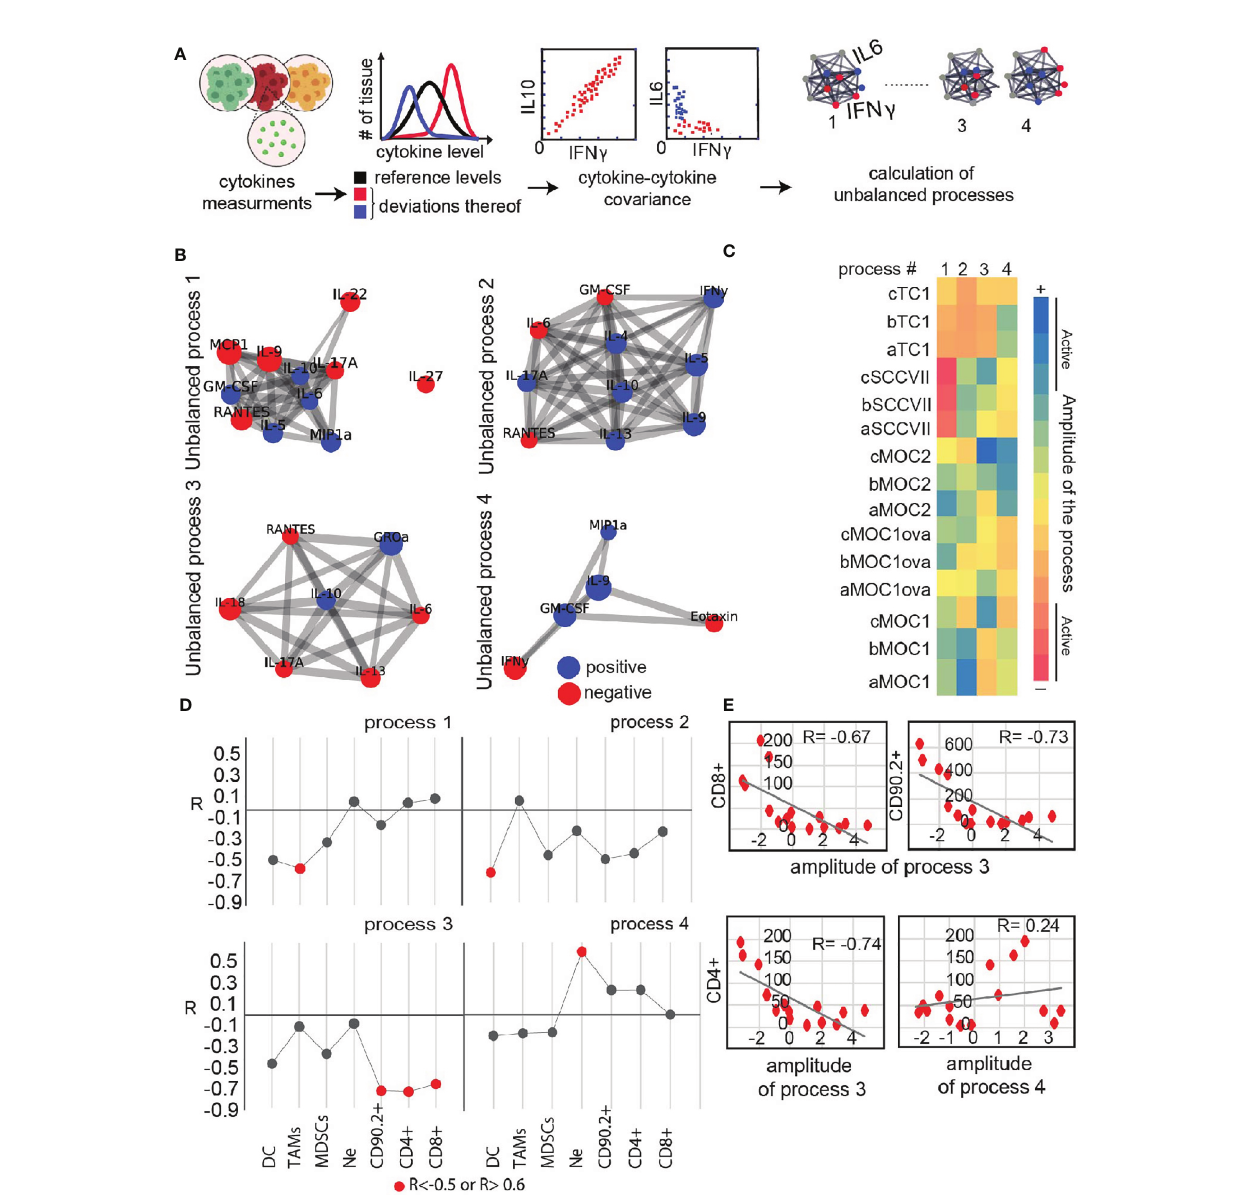
FIGURE 4 | Utilizing secretome pro fi ling to identify cytokine/chemokine expression patterns in different explants and their correlation with immune in fi ltrating cells. (A) Quantitative secretome data obtained from the cohort of HNSCC tumor models explants is used as an input for the analysis. Extent of variability in protein expression levels is quanti fi ed for each cytokine/chemokine. Protein distribution histograms are built to present and quantify this variability. Proteins whose expression levels deviate from the reference state in the same direction or in opposite directions, e.g. co-varying proteins, are grouped further into correlation networks (exempli fi ed here by IFNg, IL10 and IL6). In this example IFNg and iL10 are correlated, whereas the expression levels of IFNg and IL6 are anticorrelated and deviate from the steady state in an opposite manner. Based on these co-varying groups of proteins, altered protein-protein correlation networks are generated (right panel). Several different protein-protein correlation networks can be found in the entire population of cancer explants. (B) Four signi fi cant unbalanced processes were found in the explant dataset based on error calculation. Cytokines with signi fi cant G i a values (the cutoff was based on 20-fold difference between the 20% of cytokines with lowest G i a in this process and the cytokines considered to be involved in the process) were assembled into networks using functional interactions according to STRING database. (C) Heatmap presents amplitude values of the 4 unbalanced processes for all tumor types. Threshold limits (indicated as “ active ” in the color chart) were calculated as described (22). (D, E) Correlation plots between amplitudes of the unbalanced process and the levels of biomarkers representing in fi ltrating immune-cells were generated for each process (E) shows examples of such plots showing a correlation between process 3 and CD4 + , CD8 + , and CD90.2 + in fi ltrating cells. (D) summarizes R correlation coef fi cient values between key immune in fi ltrating cells and unbalanced co-secretion